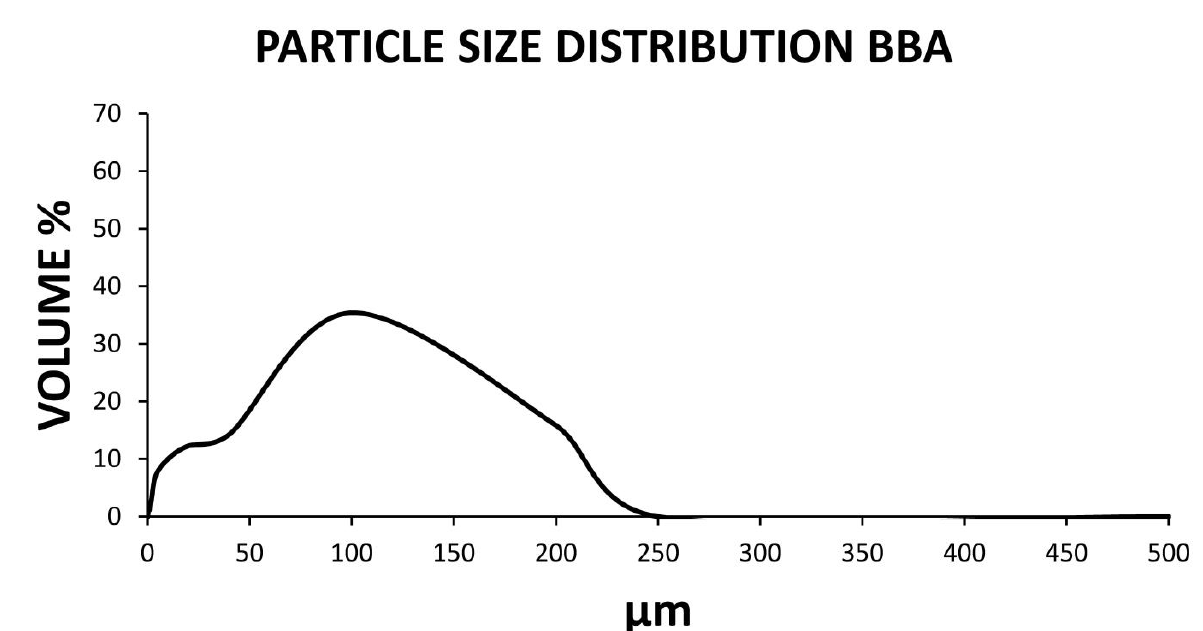
Figure 2. Graph of the laser granulometry of the sieved BBA by a 0.25 mm sieve. Once the physical properties were evaluated and the results obtained for the confor- mation of geopolymers were acceptable, the chemical properties were studied. The first test performed was that of elementary analysis, to determine the percentage of carbon, nitrogen, hydrogen and sulfur present in both samples. Table 2. Elemental analysis of the chamotte and the BBA. Sample